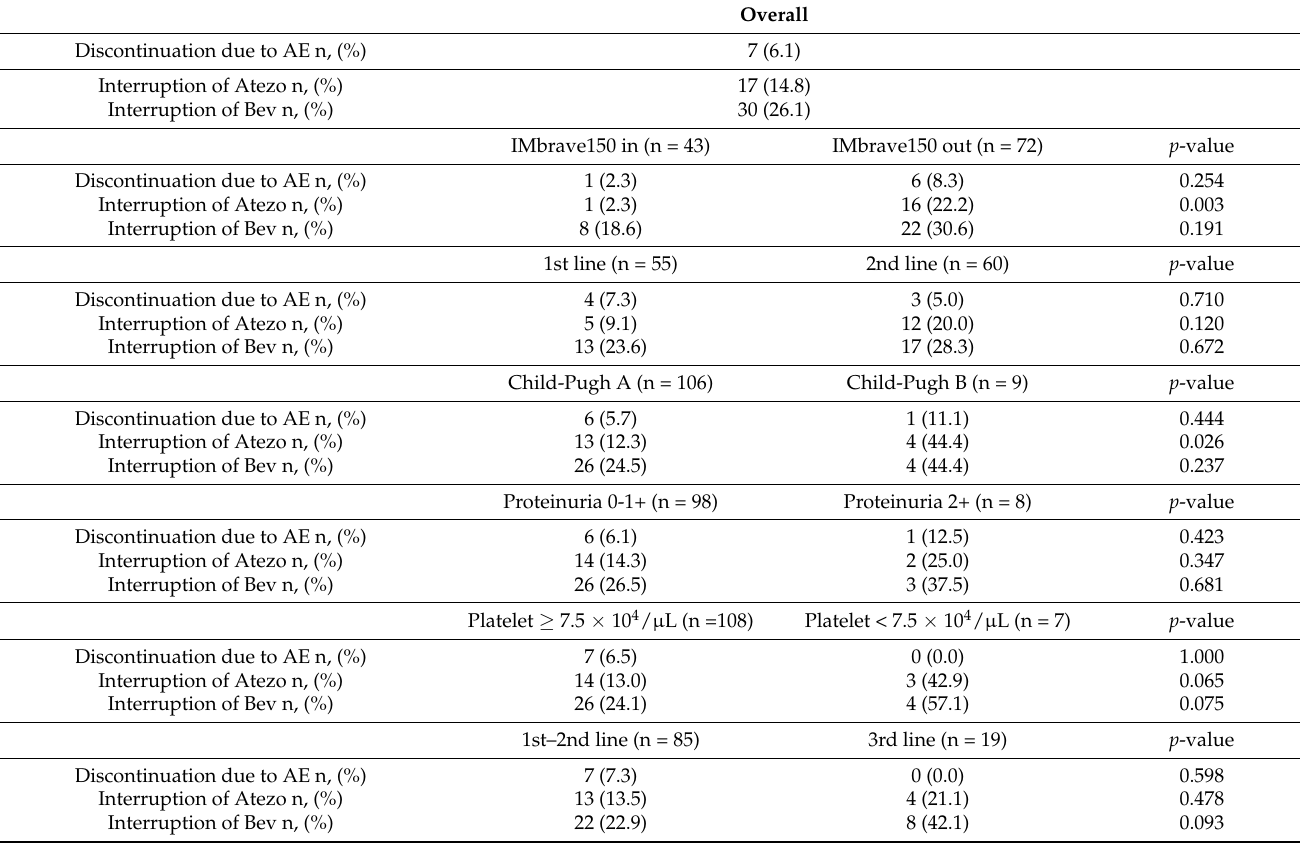
Figure 4. Comparison of changes in the ALBI score and mALBI grade during atezolizumab and beva- cizumab treatment for unresectable HCC in subgroups stratified by eligibility criteria of IMbrave150 and history of systemic therapy. mALBI: modified albumin-bilirubin grade. Table 4. Comparison of the rate of treatment discontinuation and interruption in patients who were treated with atezolizumab and bevacizumab in each